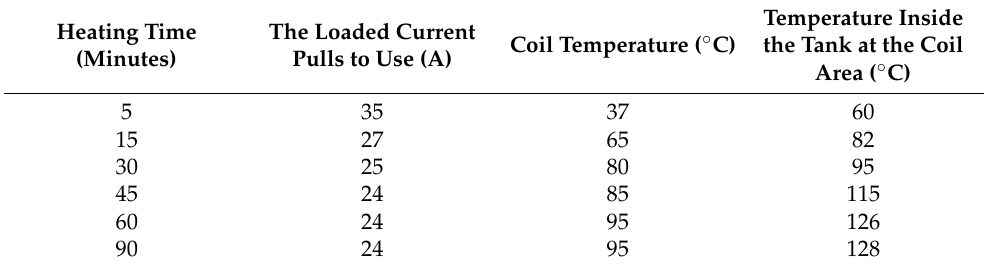
Table 4. We measured the average heating value of each coil formed on the housing over time and checked the current consumed by the load when using the heater. The apparatus consisted of two machines and four copper wire